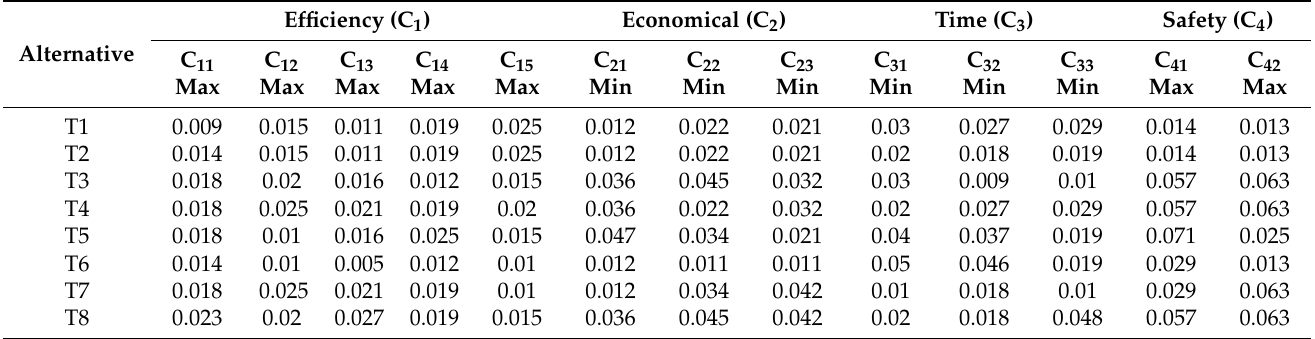
Table 21. The weighted normalized value of all the business process modelling tool alternatives in Table 4.